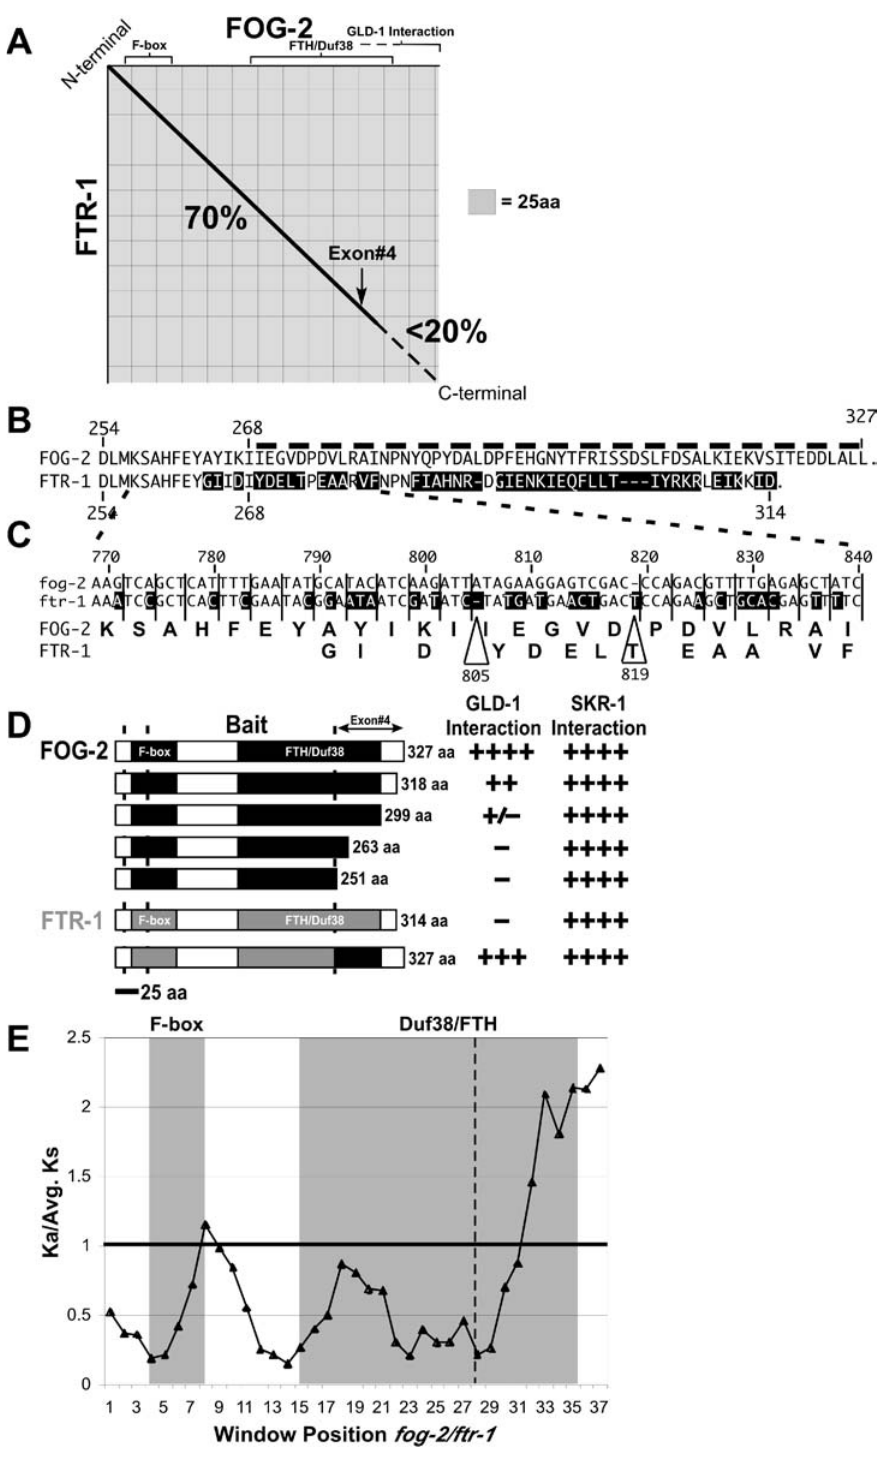
Figure 4. The Highly Diverged FOG-2 C- Terminal Region Is Responsible for GLD-1 Interaction in C. elegans (A) Dot plot of FOG-2/FTR-1, with the black diagonal line delimiting regions of greater than 70% identity based on a 10- aa sliding window. The dashed horizon- tal line at the C-terminus indicates a region of low identity. The arrow in- dicates the final exon 4 boundary. (B) Protein sequence alignment of FOG- 2 and FTR-1 encoded by exon 4. Differ- ences are shaded in black and illustrate the abrupt breakdown in sequence con- servation. The dashed line marks the region required for GLD-1 interaction. (C) Nucleotide alignment of fog-2 and ftr- 1 EST coding regions expanded from a portion of the protein sequence align- ment, with vertical lines delimiting the reading frame relative to fog-2.